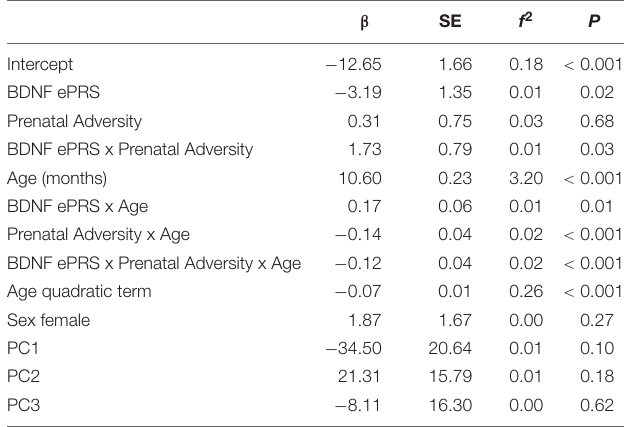
TABLE 4 | Descriptive statistics of scaled cognitive developmental ability estimates of the Bayley Mental items.